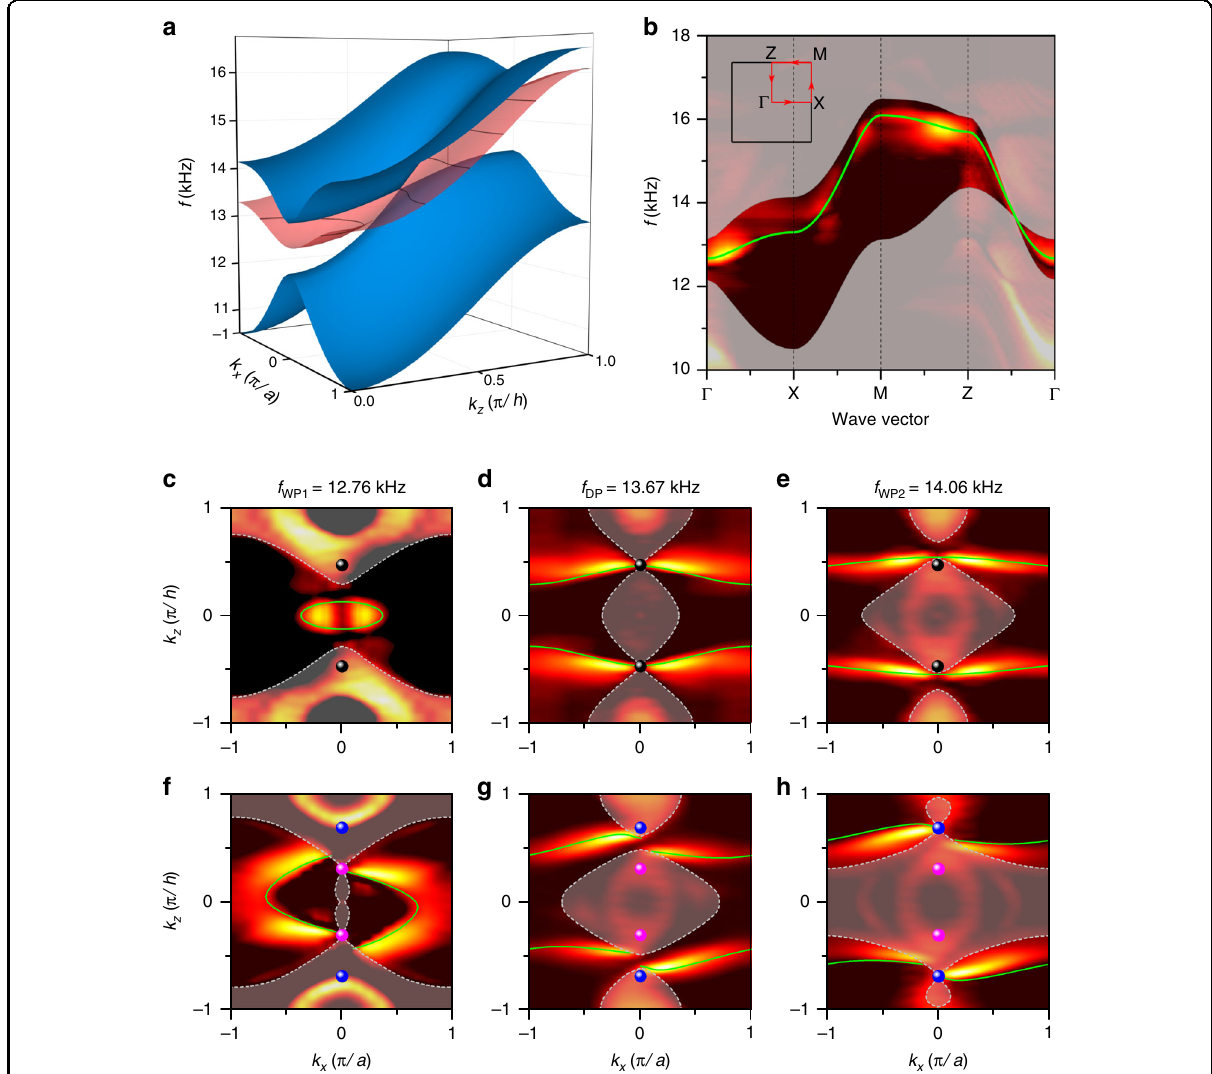
Fig. 3 Surface states with a zigzag hard boundary. a 3D surface band structures of projected bulk states (blue) and surface states (red). b Surface band structure along the high-symmetry line of the surface Brillouin zone. c – h Equifrequency contours of the surface state for the c – e Dirac and f – h Weyl sonic crystals at frequencies of 12.76 kHz (WP1), 13.67kHz (DP) and 14.06 kHz (WP2). The green lines represent the calculated surface states, while the shaded areas represent the calculated projected bulk bands. The black spheres represent the projections of the Dirac points. The pink and blue spheres represent the projections of the Weyl